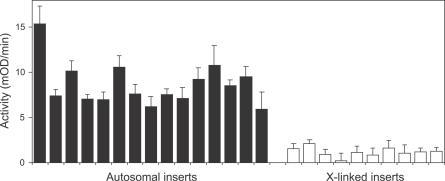
Average β-Galactosidase Activity of Adult Male Flies with Autosomal (Solid Bars) or X-Linked (Open Bars) Insertions of P[wFl-ocn-lacZ]
Each bar represents a different transformed line with a unique, independent transgene insertion. Error bars indicate the standard error of the mean, calculated from the variance among all replicate measurements within each independent insertion line.